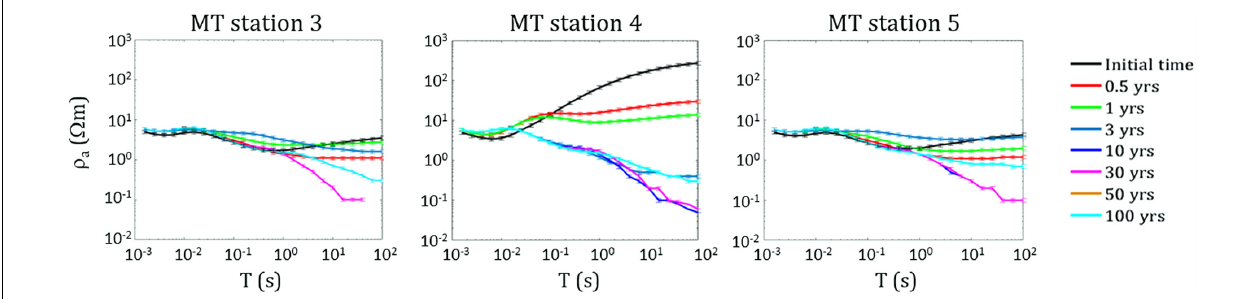
FIGURE 12 | Scenario II. Apparent resistivity curves as a function of period calculated for the three central MT stations at seven different simulation times.